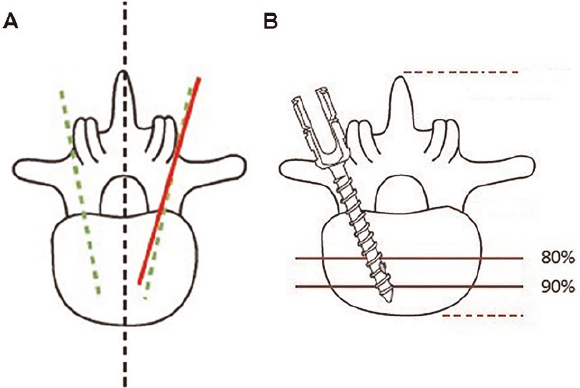
Figure 2 – A: The screw insertion angle is made slightly larger than that of a conventional pedicle screw (shown with a solid red line). B: When determining the proper screw length, a circular side hole in the anterior 80% to 90% of the vertebral body is appropriate.